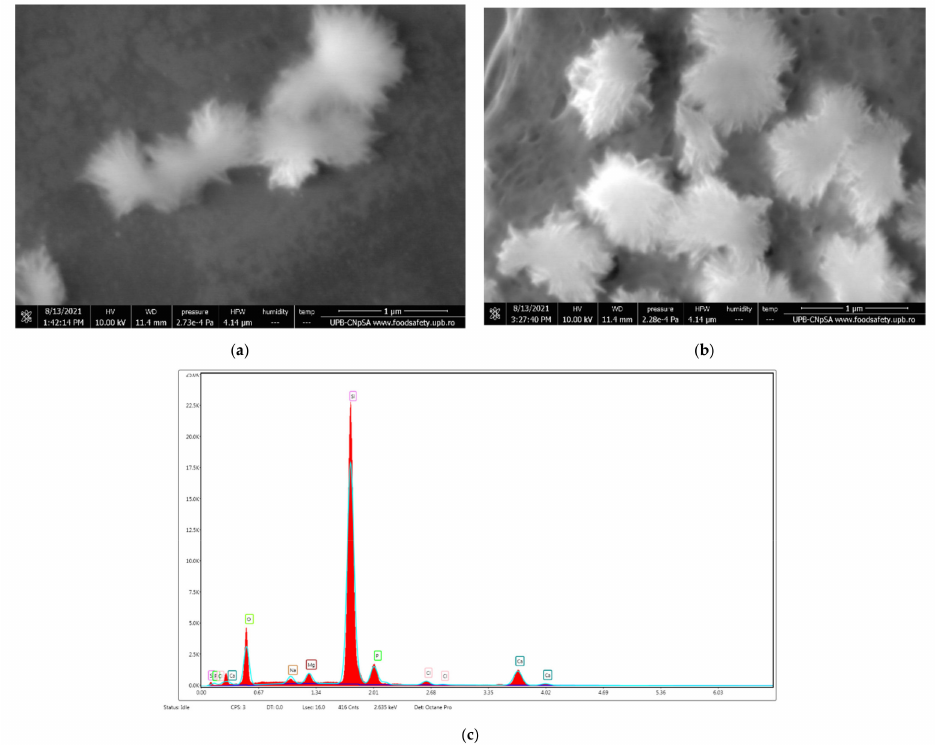
Figure 19. SEM images ( a , b ) and EDS analysis ( c ) of Fe 3 O 4 @ β -CD after 14 days of incubation in SBF at 37 ◦